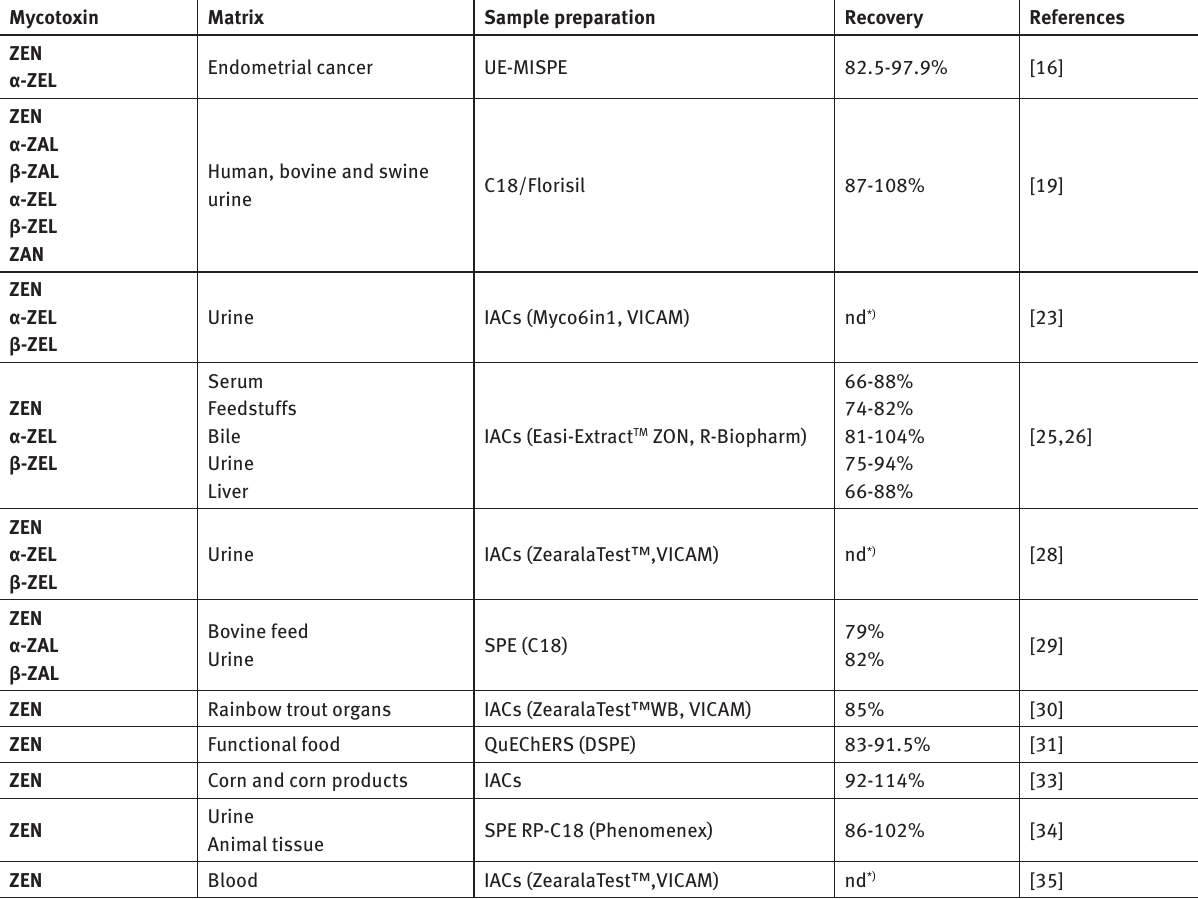
Table 1: Solid-phase extraction with different sorbents and a comparison of recovery values Mycotoxin